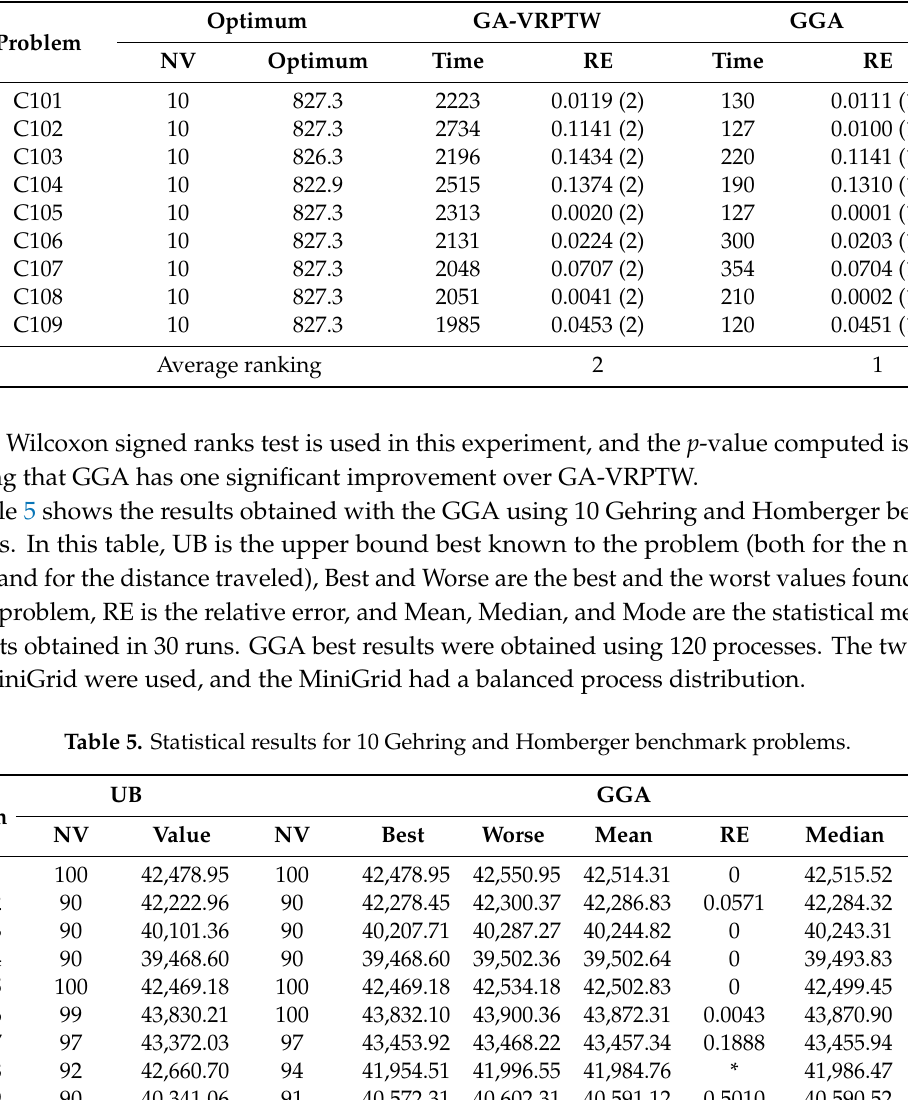
Table 4. Results comparison between GA-VRPTW and GGA with Solomon benchmark problems.